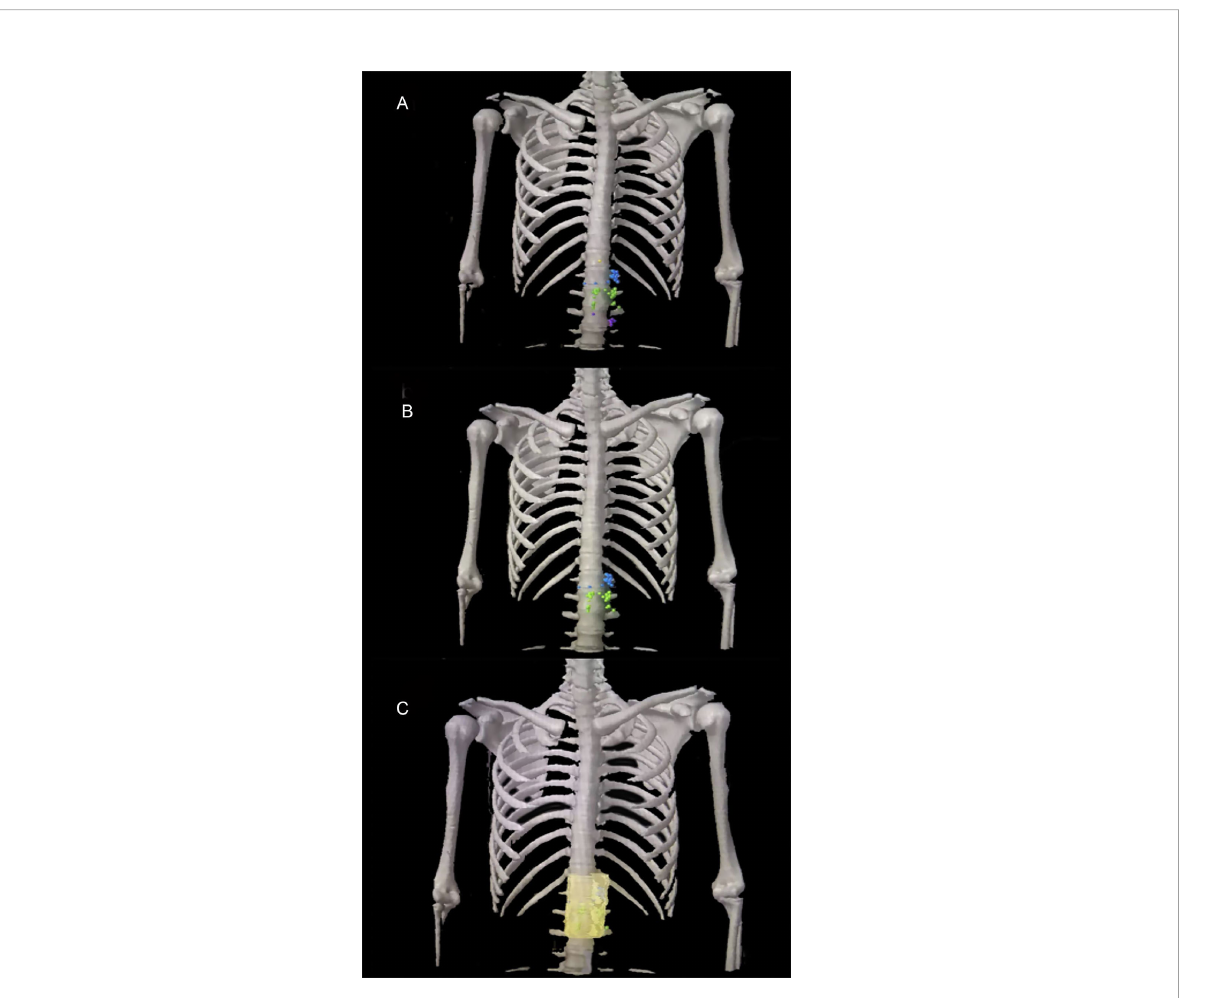
FIGURE 4 The para-aortic CTV coverage in the validation cohort. (A) PALN map in the validation cohort. (B) Lymph node map of regions 16a2 and 16b1 in the validation cohort. (C) Coverage of the para-aortic CTV in the validation cohort. CTV, clinical target volume; PALN, para-aortic lymph node. Orange plot, metastatic lymph nodes in 16a1; blue plot, metastatic lymph nodes in 16a2; green plot, metastatic lymph nodes in 16b1; purple plot, metastatic lymph nodes in